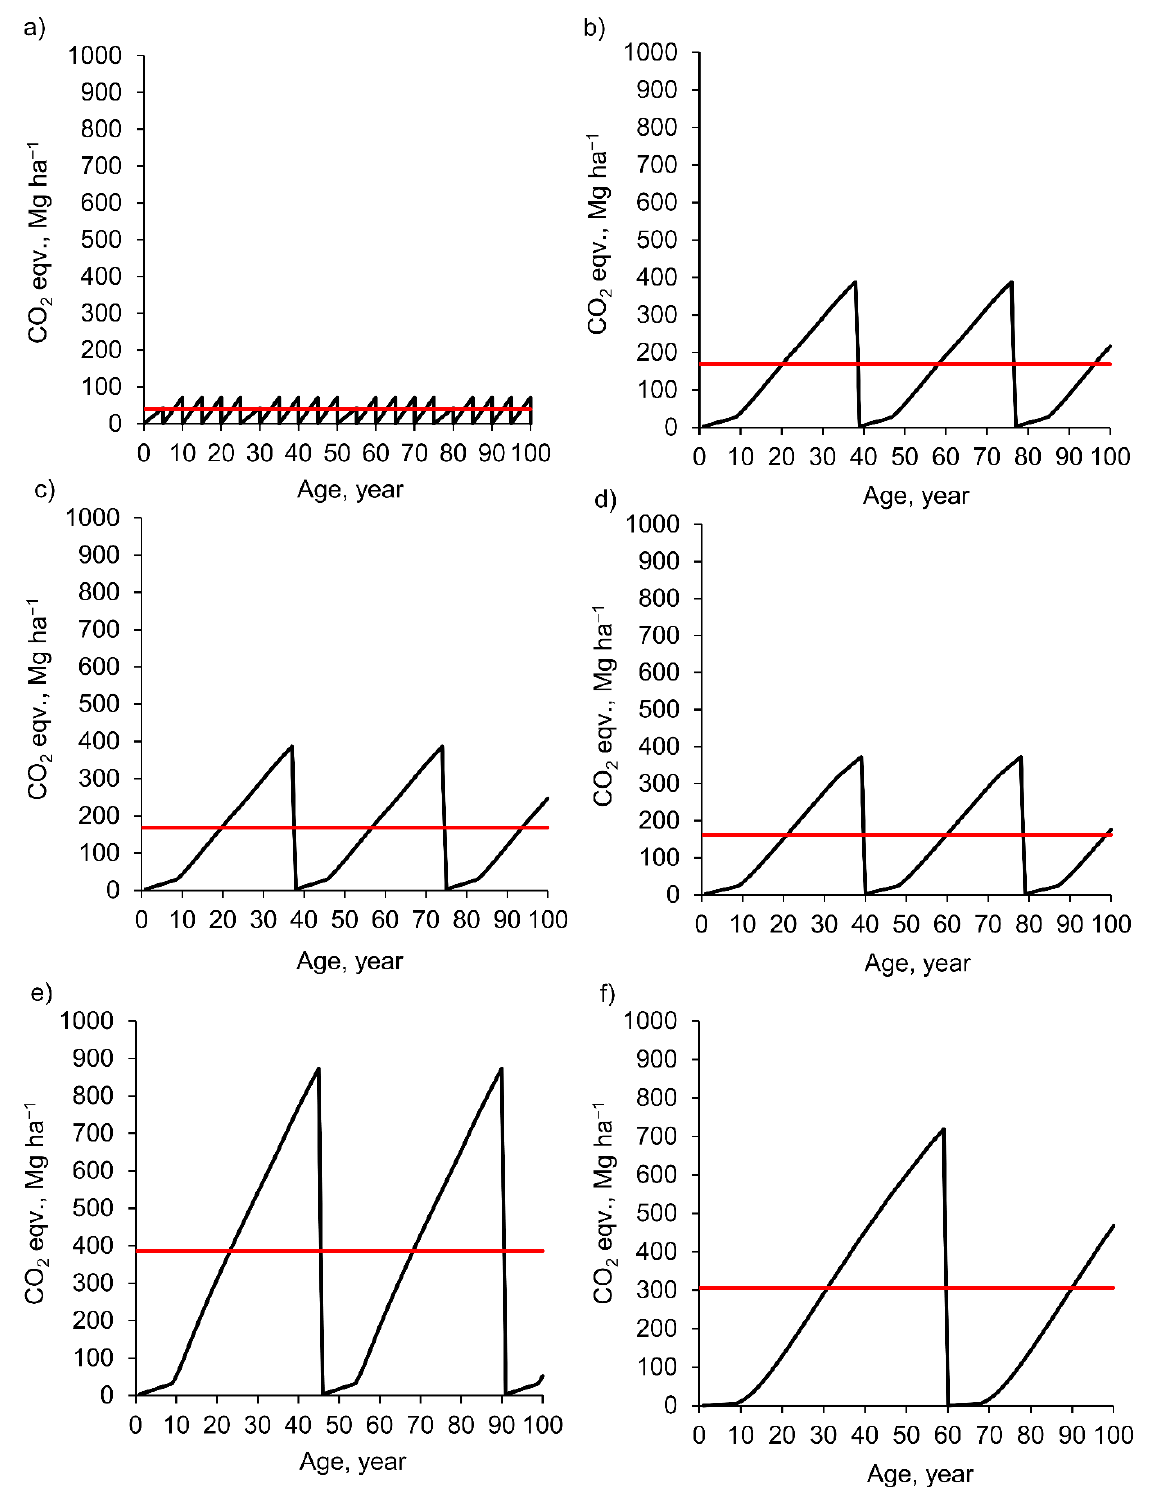
Figure 1. The development of C stock (expressed as CO 2 eqv.) over the rotation cycle and the average C stock (red line) of a full rotation cycle (stem wood, branches and roots) for willow ( a ), aspen ( b ), poplar ( c ), birch ( d ), larch ( e ) and spruce ( f ).